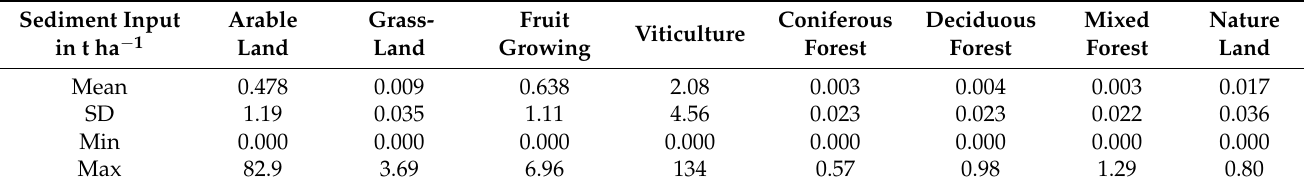
Table 5. Sediment input in t ha − 1 in the catchment of the Kraichbach